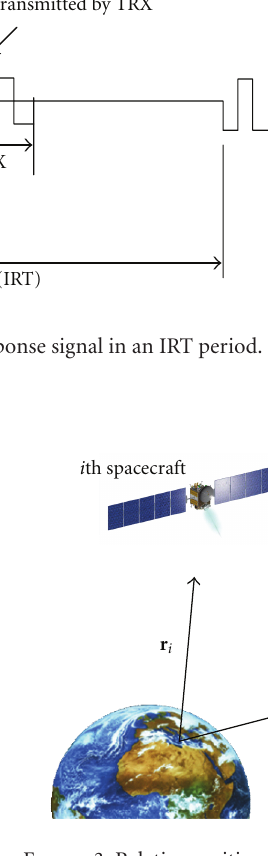
Figure 3: Relative position vector between two